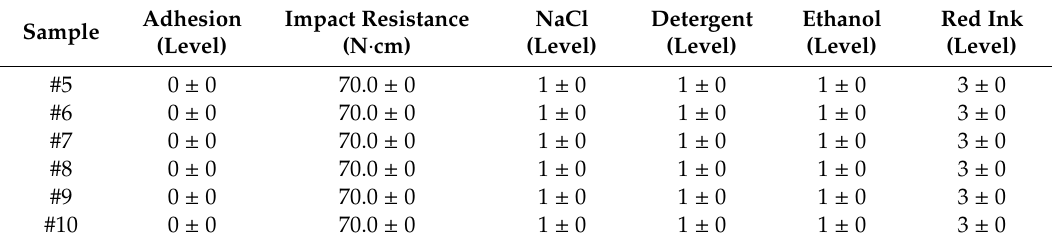
Table 10. E ff ect of coating technologies on adhesion level, impact resistance, and liquid resistance level of the reversible color-changing